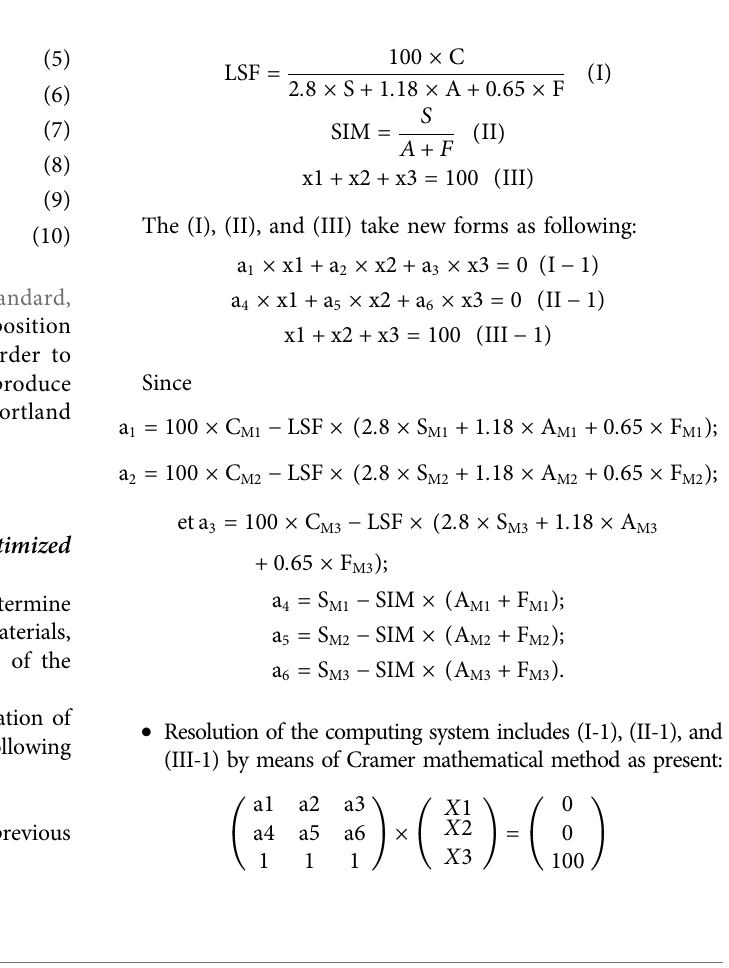
Frontiers in Chemistry |